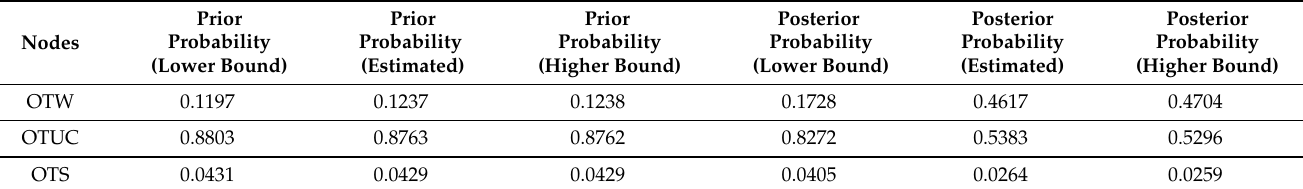
Table 11. Prior and posterior probabilities for evidence in high-risk areas of England cattle